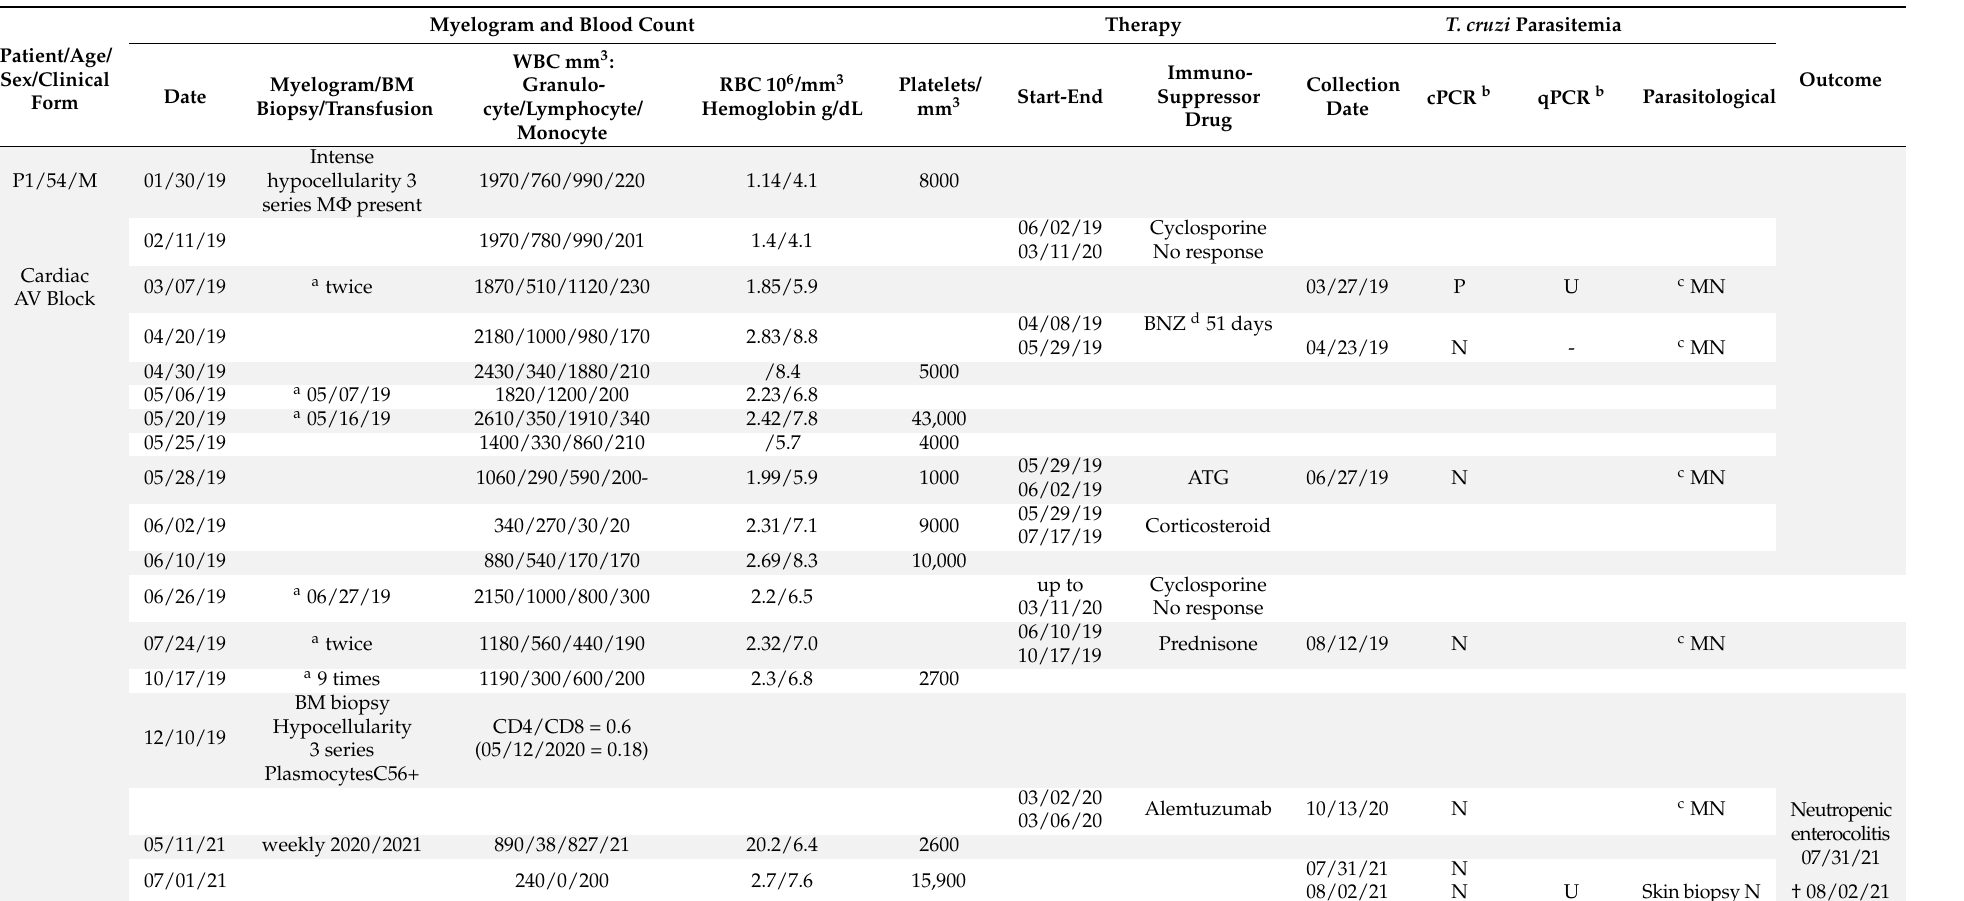
Table 1. Follow-up of one patient with aplastic anemia and chronic Chagas disease (P1) according to hematological parameters, parasitemia, antiparasitic (benznidazole), and immunosuppressive and antiparasitic